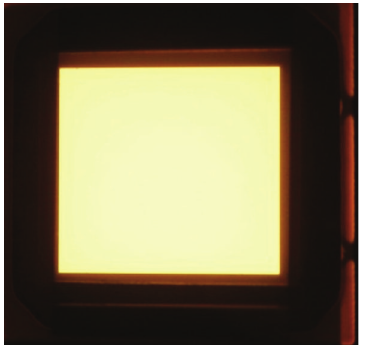
Figure 10: The OLED device illuminated at 3.5